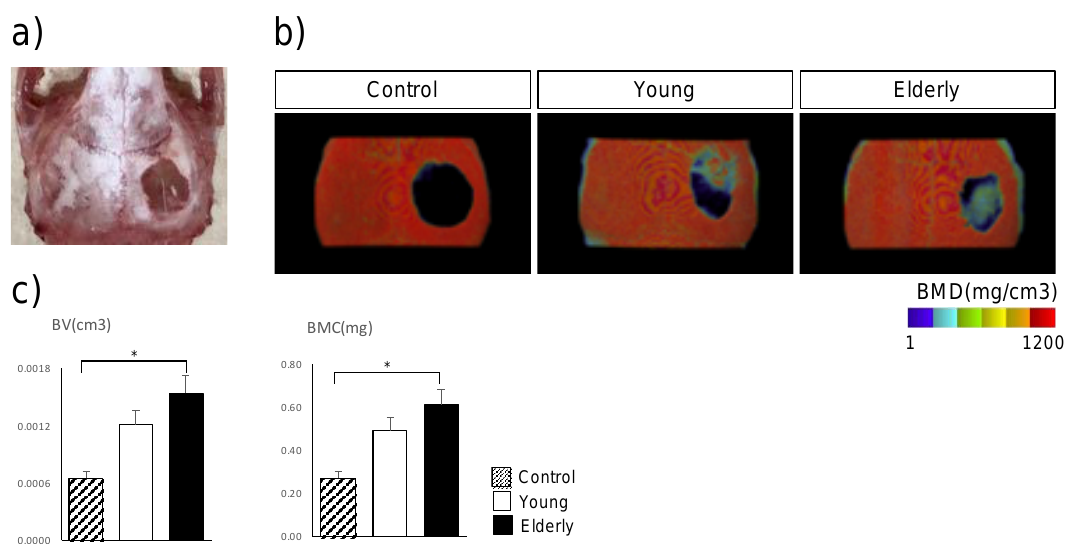
Figure 5. Radiological findings of mouse calvarial defects 8 weeks after transplantation with cell sheets of TH-induced dental pulp stem cells (DPSCs) from young and elderly patients. ( a ) TH-induced DPSC sheets were cultured on temperature-responsive dishes for 14 days and then transplanted into mouse calvarial defects (3.5 mm in diameter). Eight weeks after transplantation, we dissected the calvaria ( n = 4). ( b ) Micro-computed tomography images indicated the bone mineral density (BMD) values. The experiments were repeated three times, and one representative image is shown. ( c ) Quantification of bone volume (BV) and bone mineral content (BMC) of a 5 × 5 × 3 mm 3 cuboid area in the center of a circular defect. Data are expressed as means ± standard deviation of five mice per group. * p < 0.05 by Student’s unpaired two-tailed t -test.